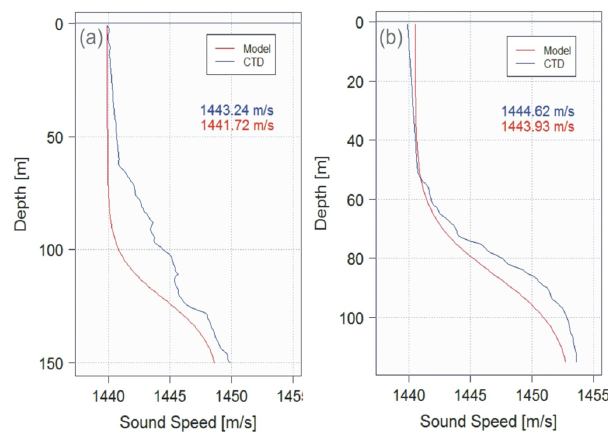
Figure 8. (a) Blue: vertical sound speed profile calculated from a CTD measurement on 16 December 2002 using the TEOS-10 Gibbs SeaWater Library (Wright et al., 2010). Red: the profile at the same time, calculated with the sound speed model using T uls . The num- bers are the vertical harmonic means of the profiles. The di ff erence between both vertical averages of 1.52ms − 1 would cause an error in the ice draft of about + 16cm. (b) Vertical sound speed profiles on 13 July 2006. The di ff erence between both vertical averages of 0.68ms − 1 would cause an error in the ice draft of about +